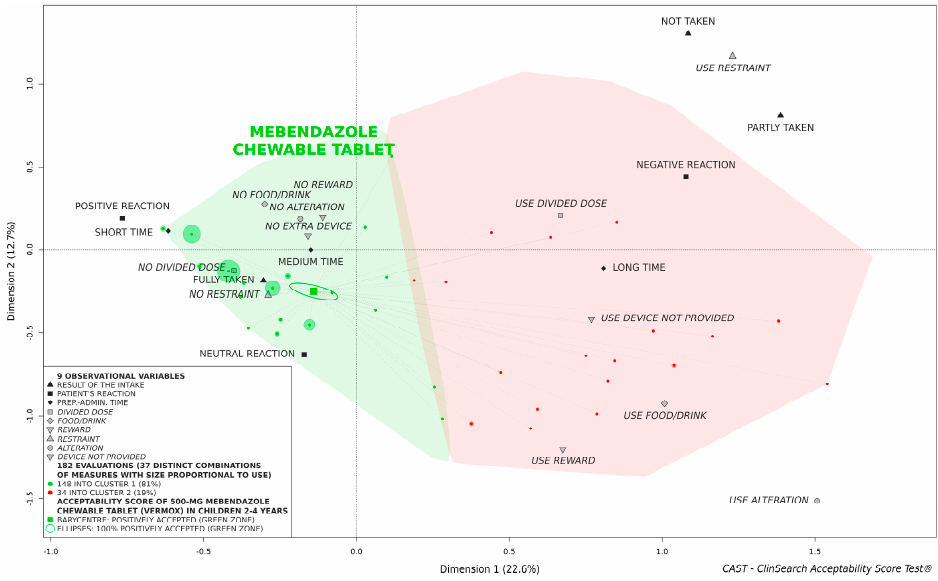
Figure 1. Acceptability of 500-mg mebendazole chewable tablet in children aged 2 to 4 years.